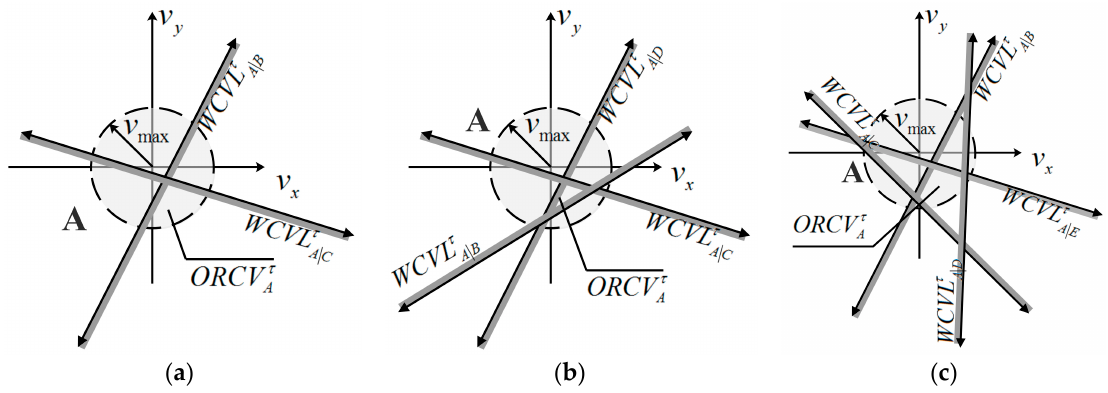
Figure 8. Three representative cases of optimization set. ( a ) ORCV is a shape of sector; ( b ) ORCV is a shape of triangle; ( c ) ORCV is an irregular shape.